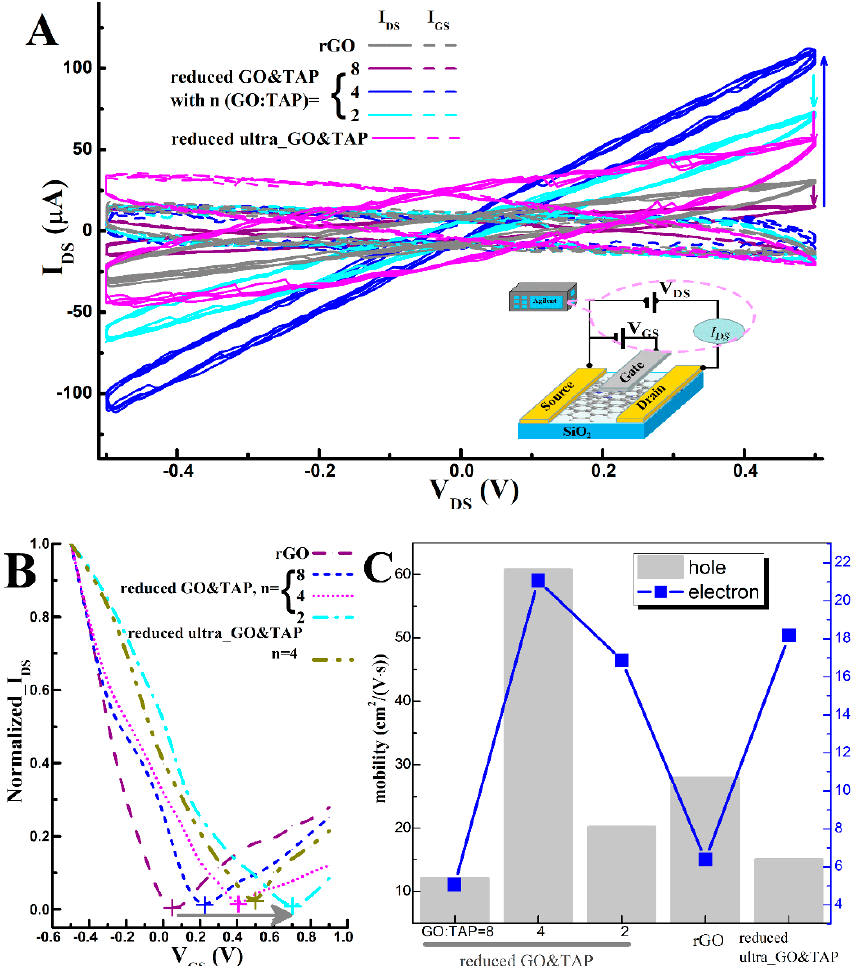
Figure 2. The electronic features of FETs channeled by di ff erent reduced products, which are reduced GO&TAP with a mass ratio of GO:TAP ( n ) = 8, 4, 2, reduced ultrasonic pretreated GO&TAP (ultra_GO&TAP, n = 4) and pure rGO. ( A ) Output features. FET’s structure and detection system are depicted in the inset. I DS is the current between the drain and source, V GS and V DS are the voltages of the gate and drain, in reference to the source. V DS is swept from − 0.5 V to + 0.5 V for 10 rounds, while V GS is controlled at 0.2 V. ( B ) The normalized transfer characteristic curves (TCCs), the measured data are presented in Figure S2 (V DS = 0.5 V). ( C ) The calculated carriers’ mobilities for the samples.